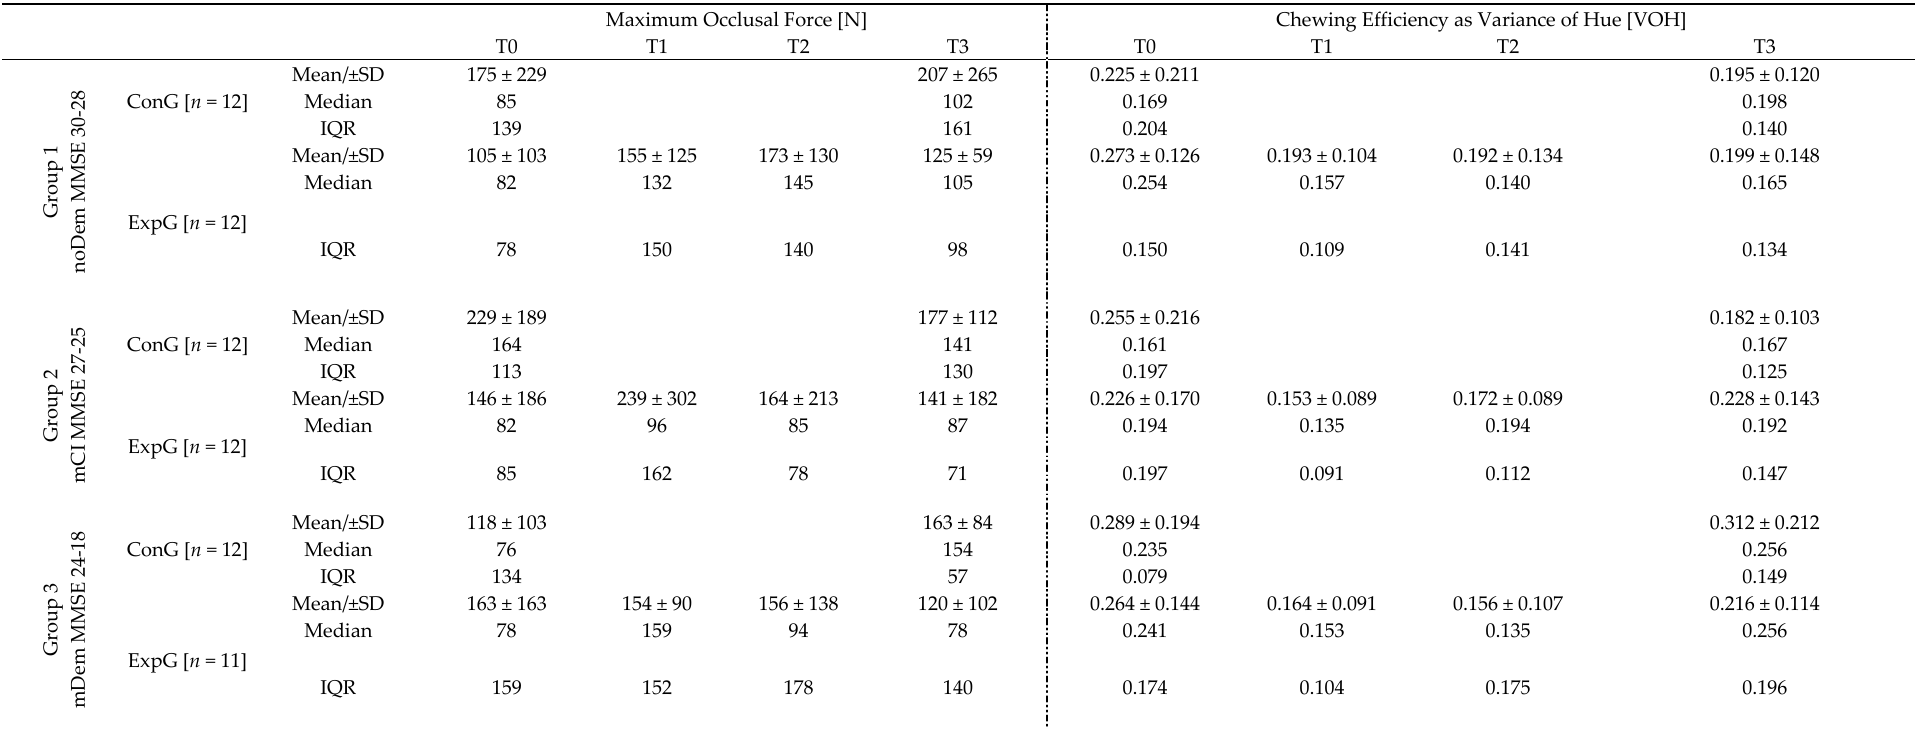
Table 1. Maximum occlusal force (MOF, in N) und chewing efficiency (Variance of Hue, VOH) separated by evaluation time-point (T0–T3) and evaluation group (group 1–3) respectively subgroup. (noDem—no dementia, mCI—mild cognitive impairment, mDem—mild dementia, ConG—control group, ExpG—experi- mental group, SD—standard deviation, IQR—interquartile